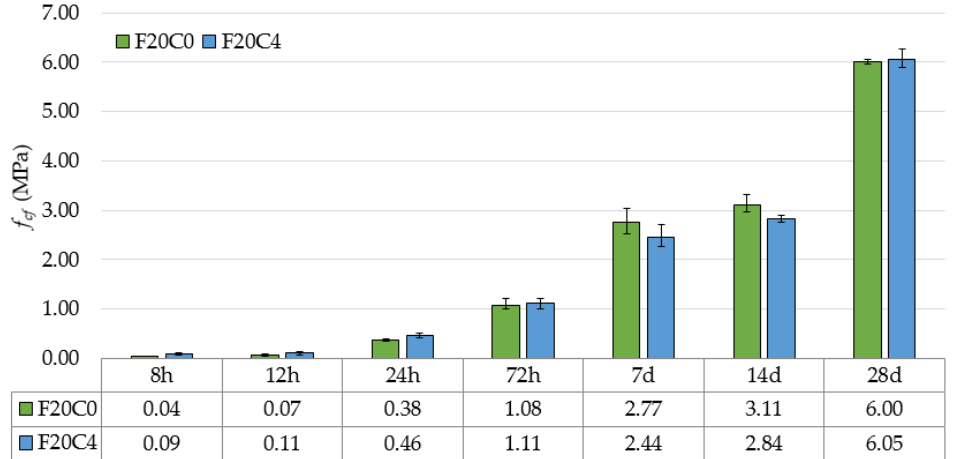
Figure 5. Results showing the tensile strengths of the cement pastes.